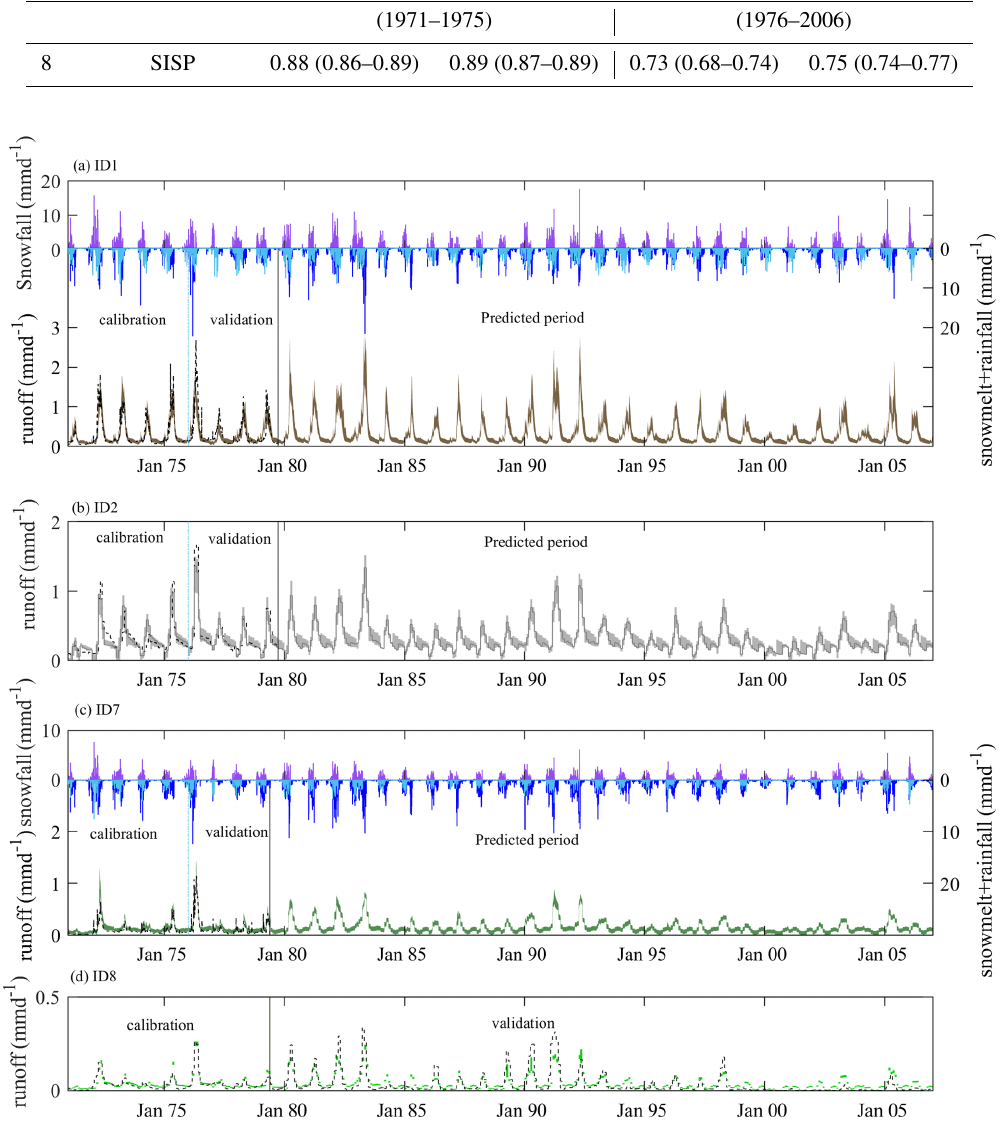
Figure 4. Precipitation and streamflow in the UHRB U (ID1), UHRB D (ID2), LHRB (ID7), and SISP (ID8). The purple bars show the modeled snowfall P S [mmd − 1 ], the dark-blue bars the modeled snowmelt M [mmd − 1 ], and the light-blue bars the modeled rainfall P R [mmd − 1 ]. The dashed black lines indicate the observed runoff and the shaded areas the uncertainty ranges of modeled runoff during calibration, validation, and prediction